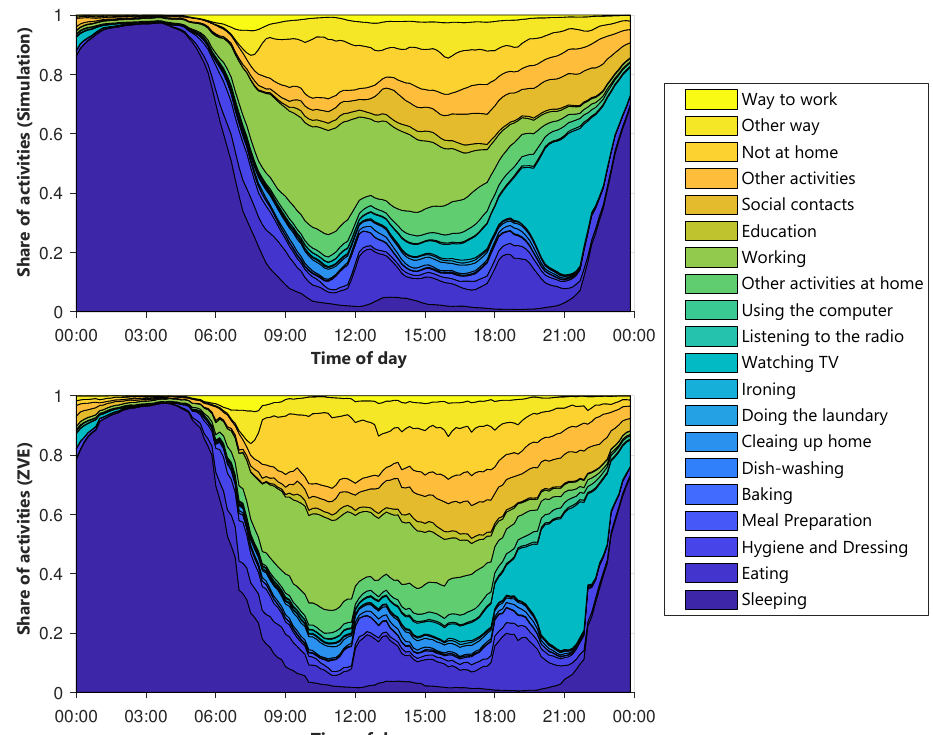
Figure A2. Average layered course of the activities for